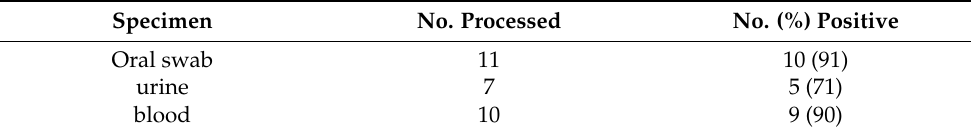
Table 5. Frequency of virus isolations from blood, urine, and oral swabs from moribund